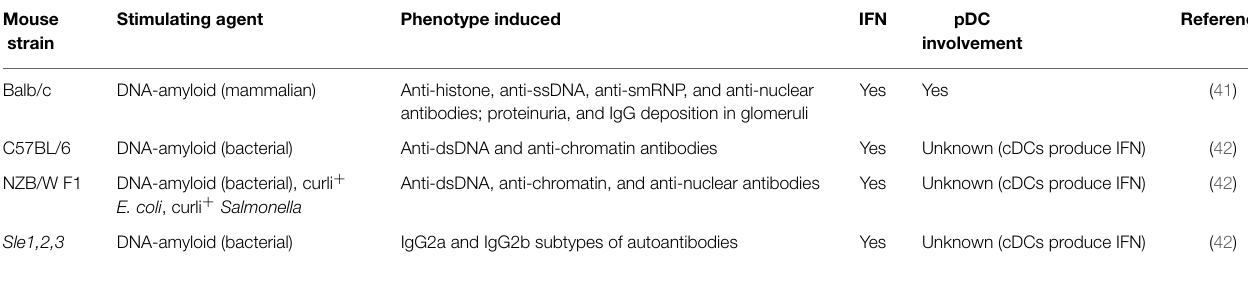
TABLE 2 | Amyloid-triggered autoimmunity in mice